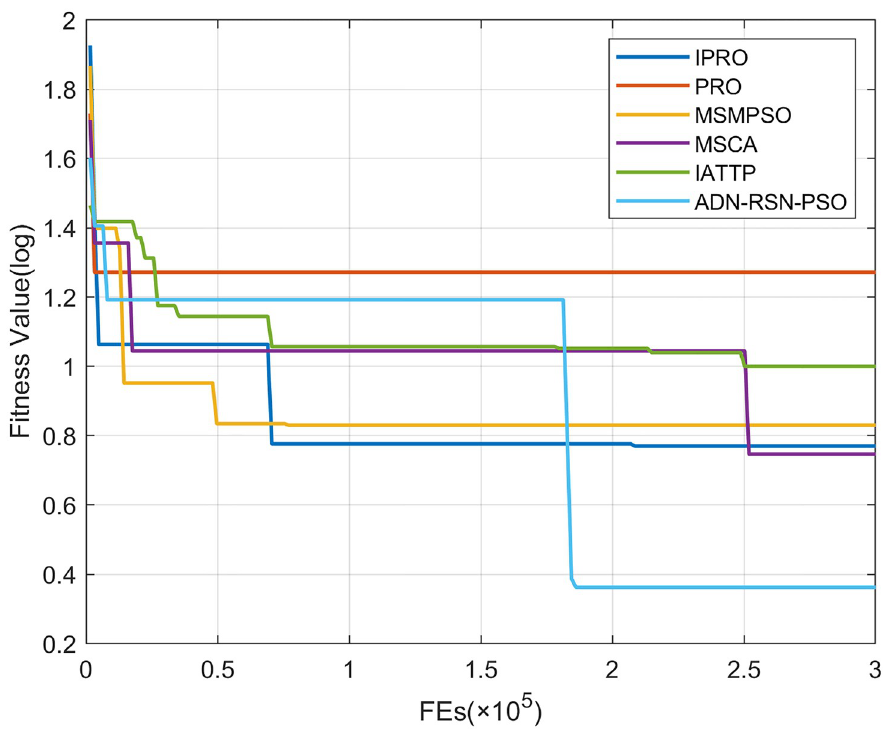
Fig 16. Convergence curves on